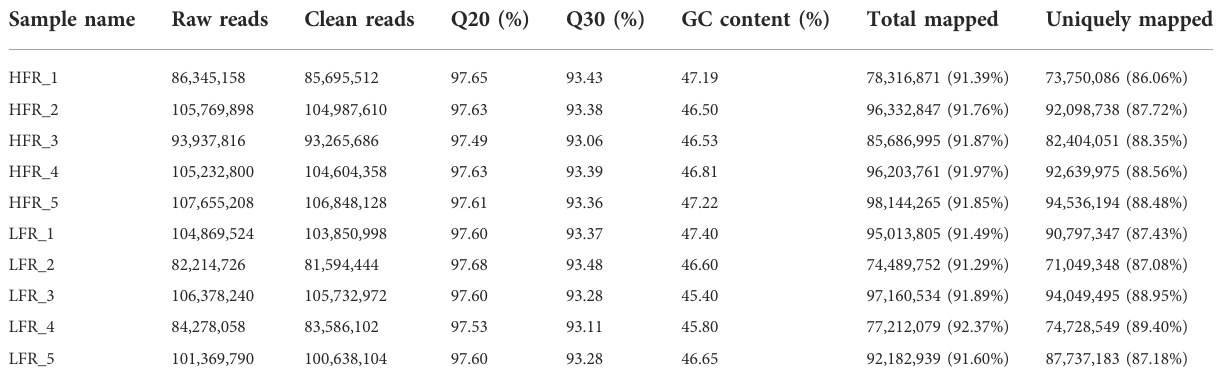
TABLE 2 Evaluation of sequencing data quality.